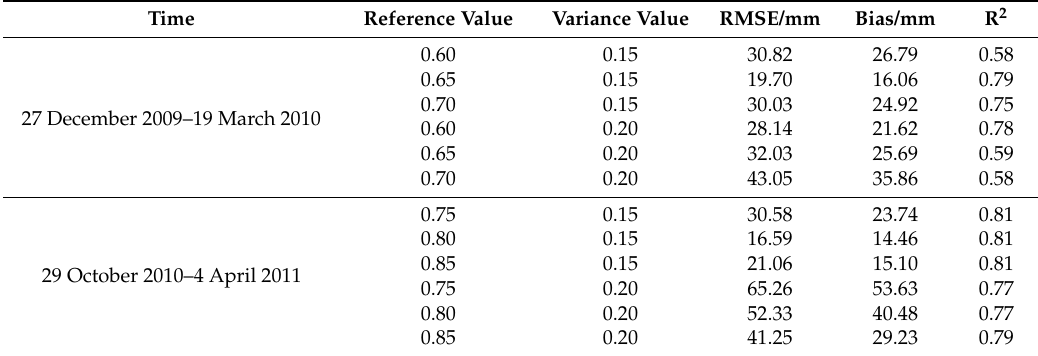
Table 6. RMSE, Bias, R 2 at Different Reference Value and Variance of